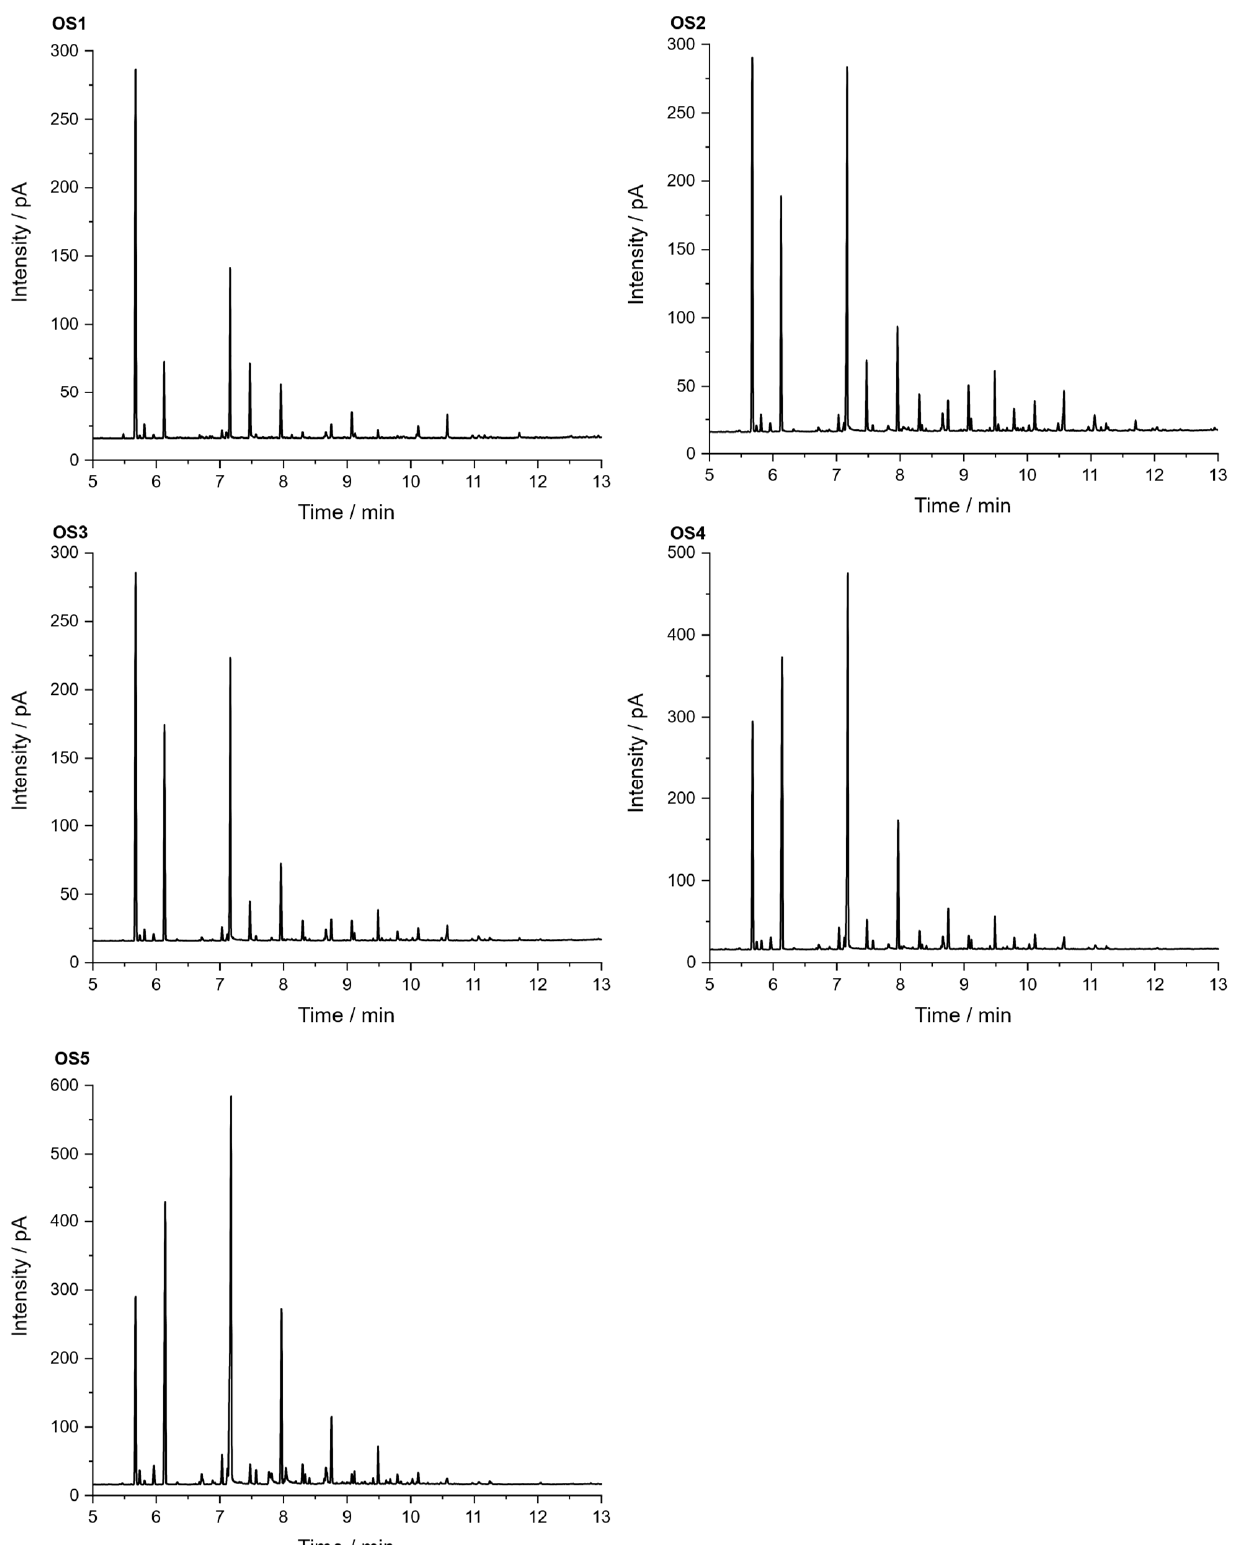
Figure A3. GC-FID chromatograms of the temperature series condensates of the spruce organosolv lignin.